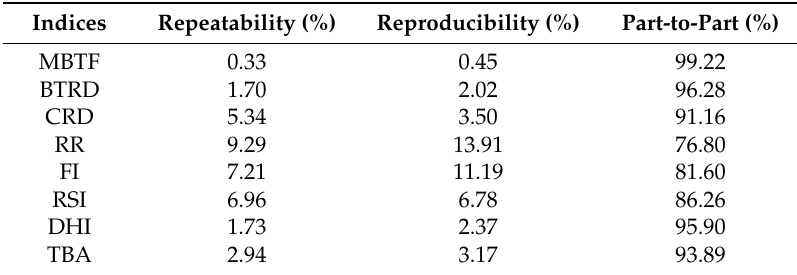
Table 5. Gage repeatability and reproducibility